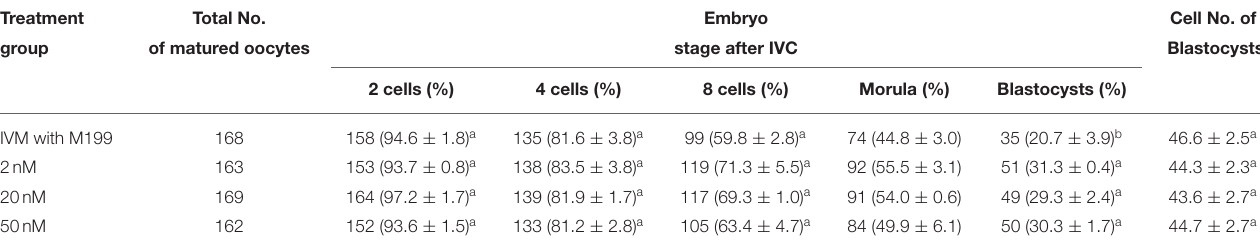
TABLE 9 | Effects of IVC media supplemented with miR-320a-3p on the development of parthenogenetic activation porcine embryos. Treatment Total No. Embryo Cell No. of stage after